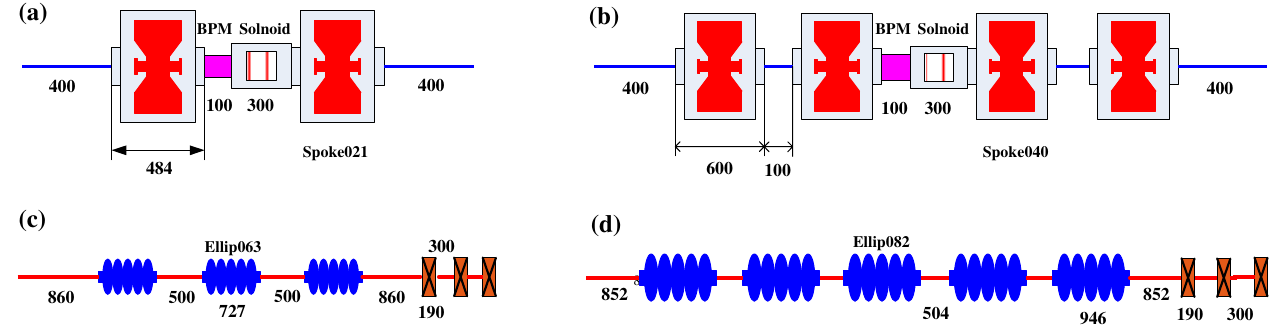
FIG. 15. Schematic view of the lattice structures for the main linac sections: (a) for Spoke021, (b) for Spoke040, (c) for Ellip063, (d) for Ellip082.